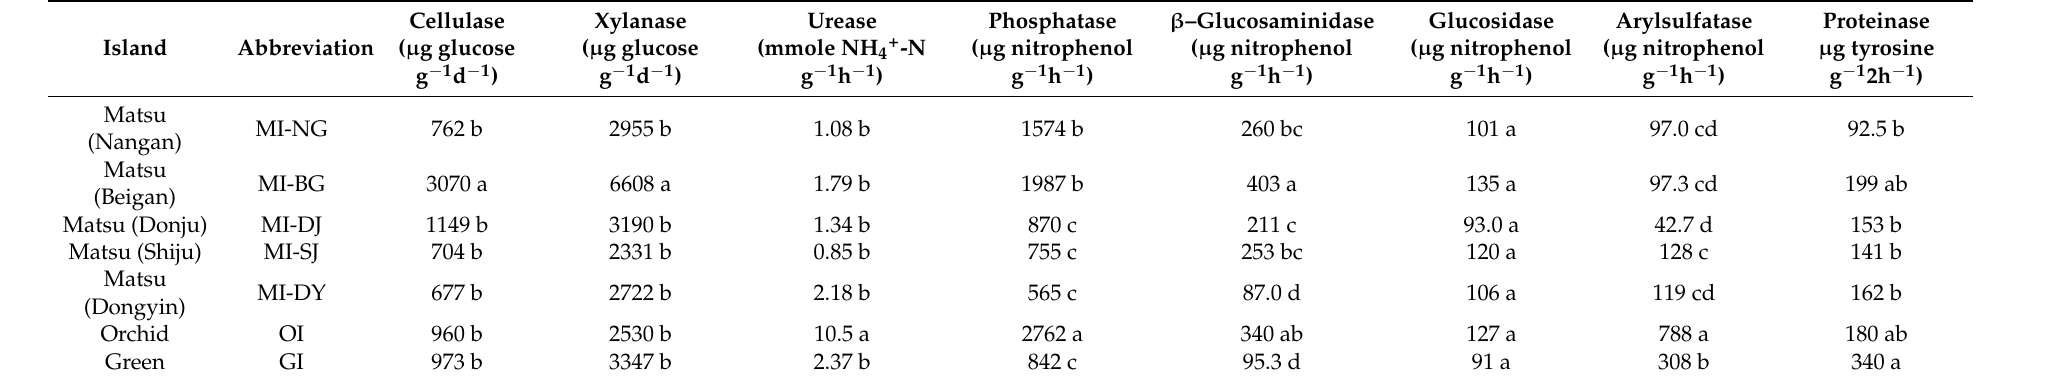
Table 2. Soil enzymatic activities of different